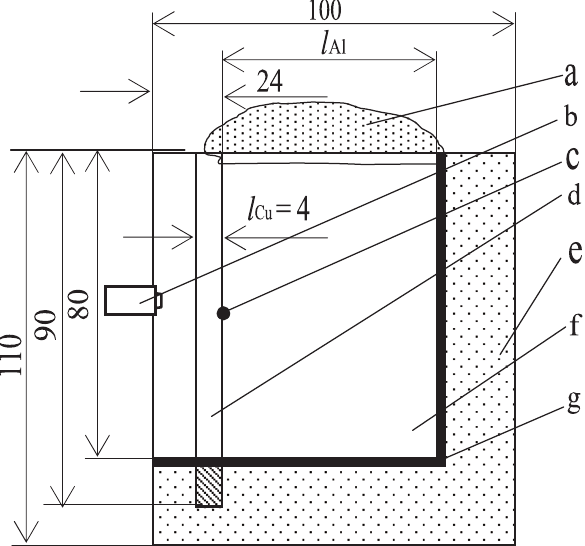
Figure 1: Compounding methods of solid Cu and liquid Al a, covering agent for thermal retardation; b, cooler; c, thermal couple; d, Cu plate; e, sand mold; f, liquid Al; g, covering material; l Cu and l Al are the thickness of Cu and Al, respectively.